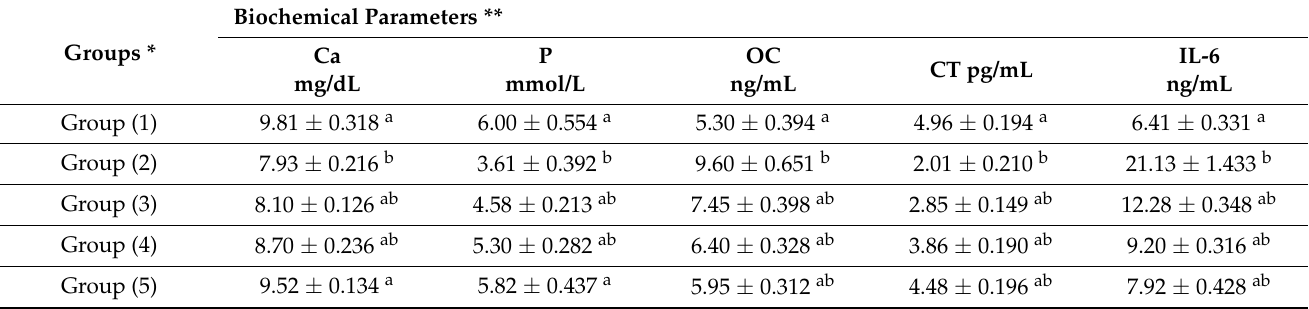
Table 1. Serum concentrations of calcium (ca), phosphorus (p), osteocalcin (OC), calcitonin (CT), and interleukin-6 (IL-6) in the control and treatment